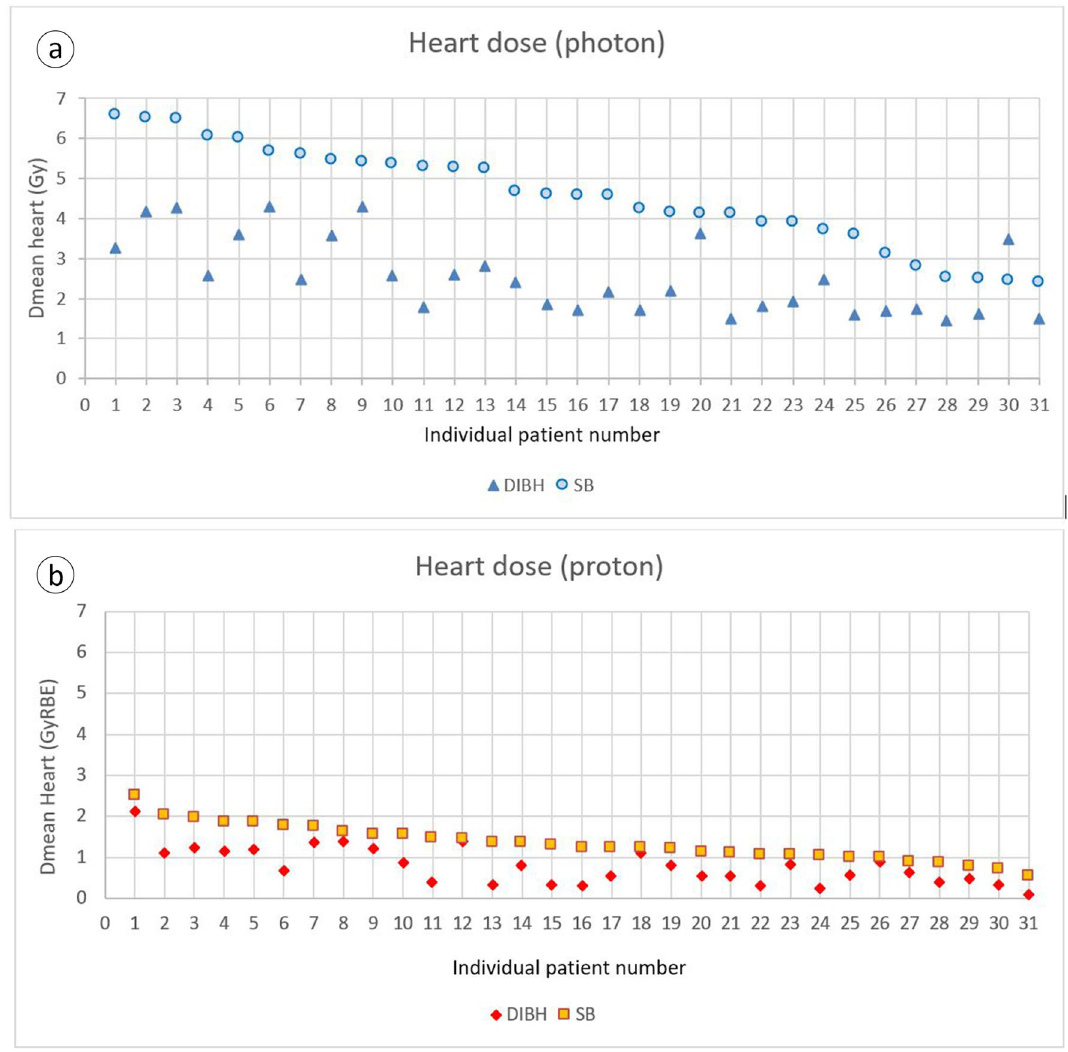
Figure 3. Plots of individual mean heart dose ranked according to decreasing SB dose for (a) photons and (b)